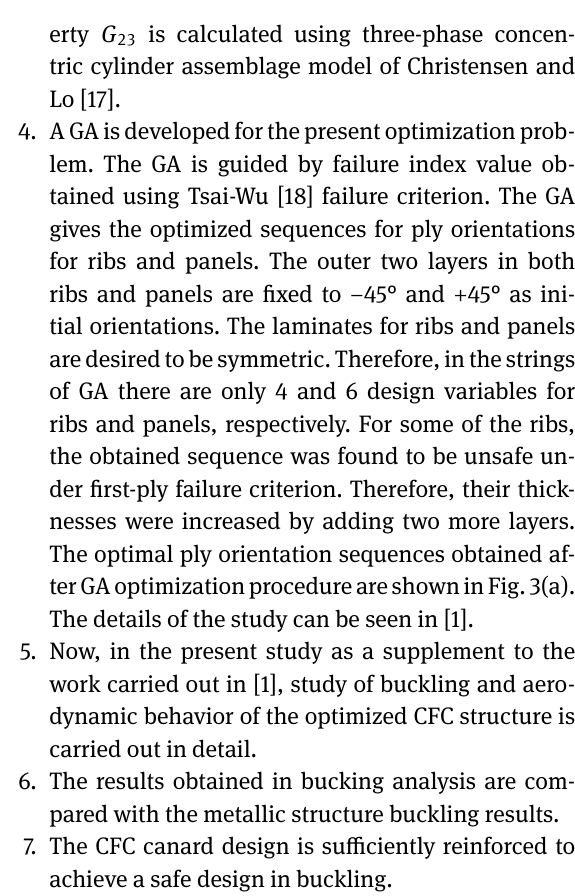
formed sheet metal members of high strength aluminum alloy of 1.5 mm and 2 mm sheet thickness,